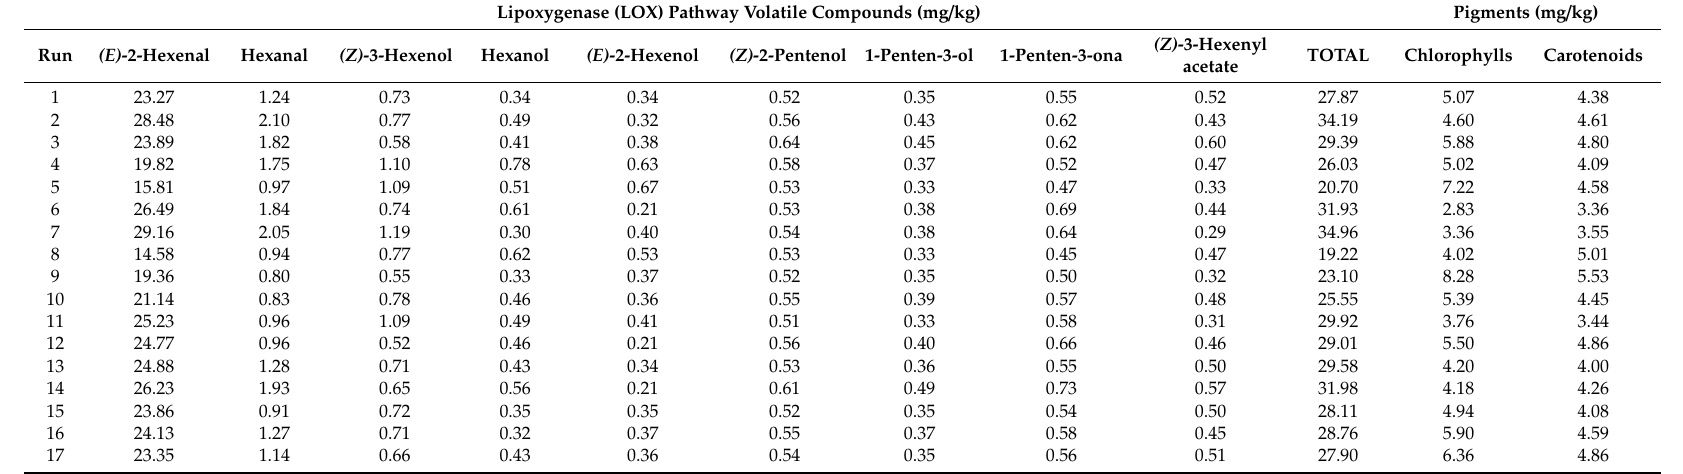
Table 2. Experimental results for the irrigated Arbequina cultivar (MI =